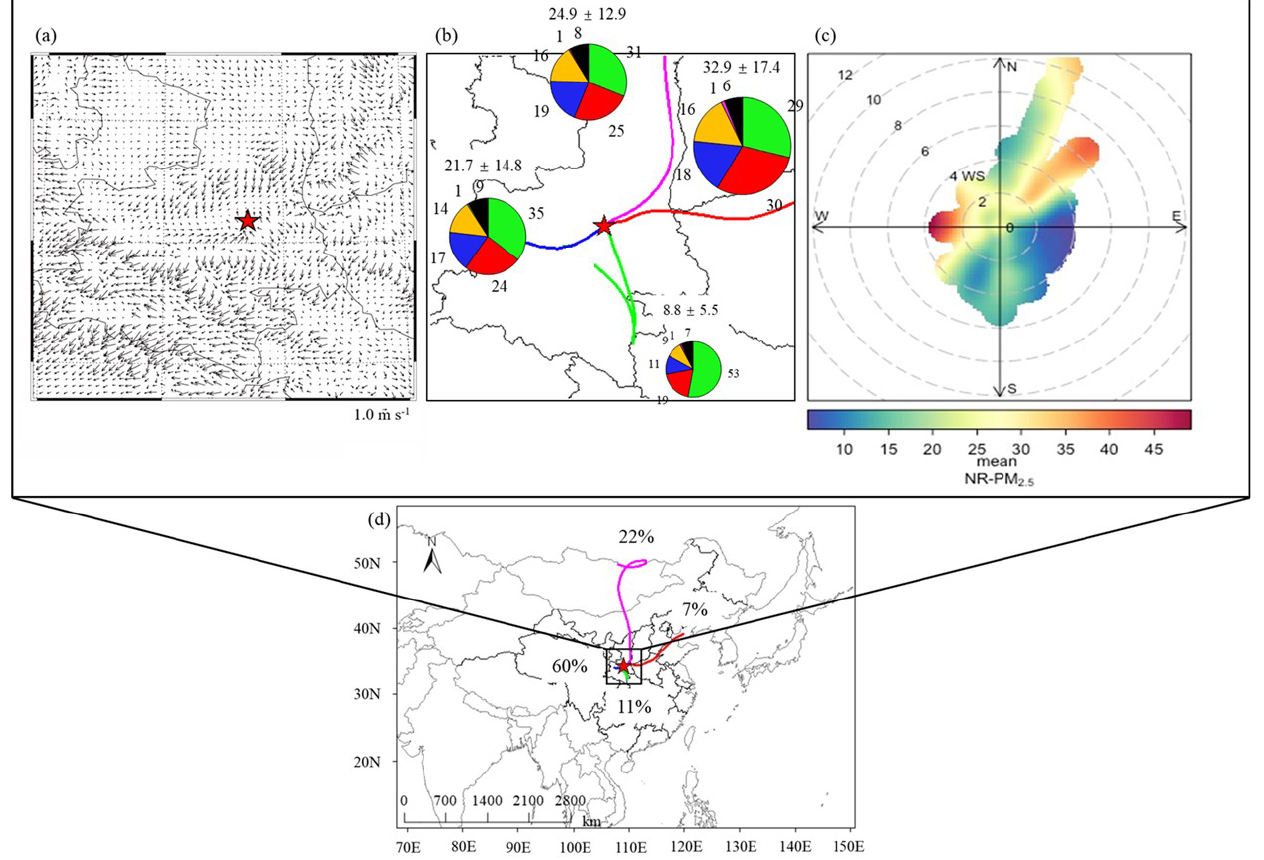
Figure 2. (a) Wind field, (b, d) backward trajectory and (c) wind rose results during the campaign. There are four transport clusters observed during the campaign, which are northern China transport (the north cluster, magenta, 22% of observation days) and BTH transport (the east cluster, red, 7% of observation days), western GZB transport (the west cluster, blue, 60% of observation days) and southern GZB transport (the south cluster, green, 11% of observation